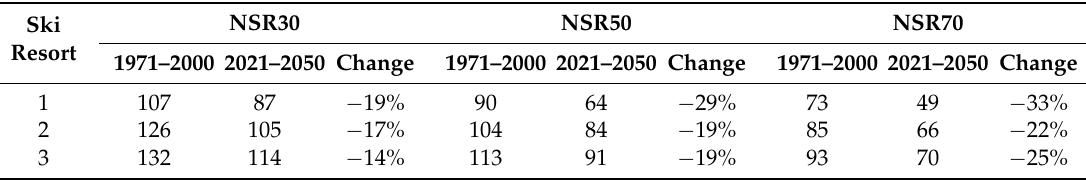
Table 2. Projected Changes for Natural Snow Reliability at the Major Ski Resorts in Northeast Turkey according to the RCP4.5